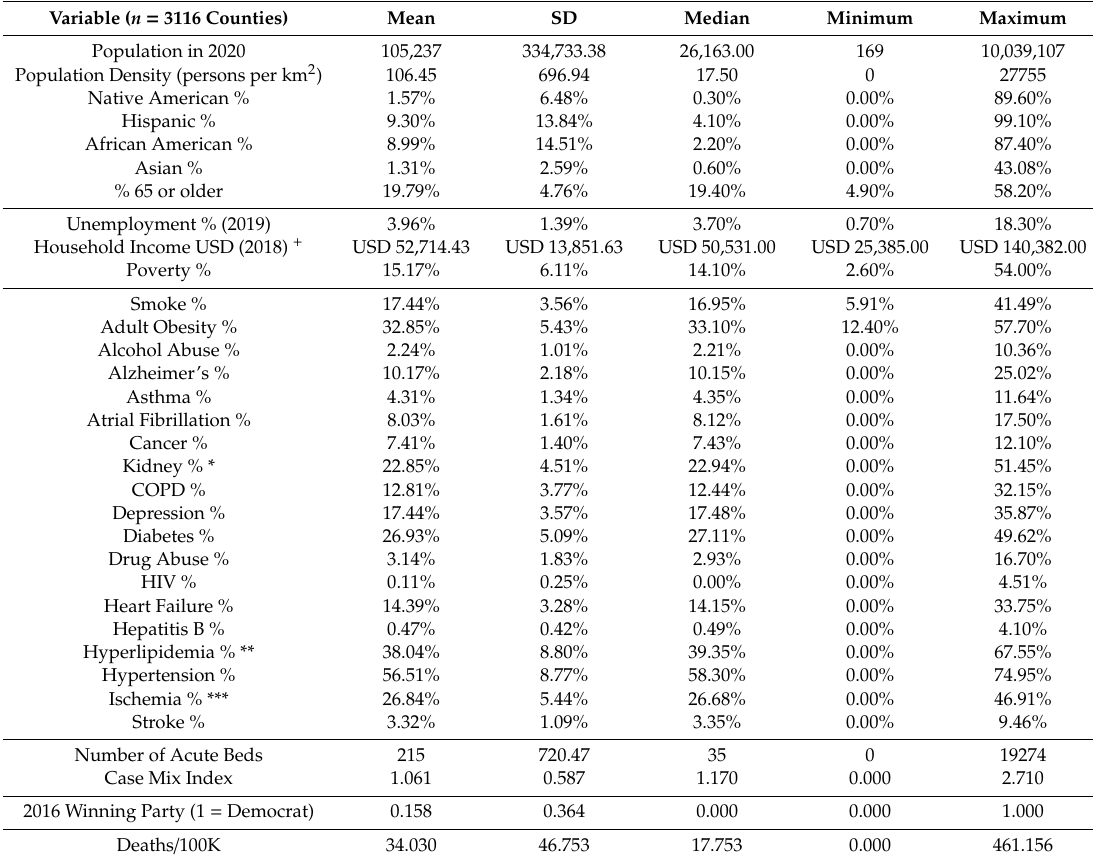
Table 1. County level descriptive statistics.